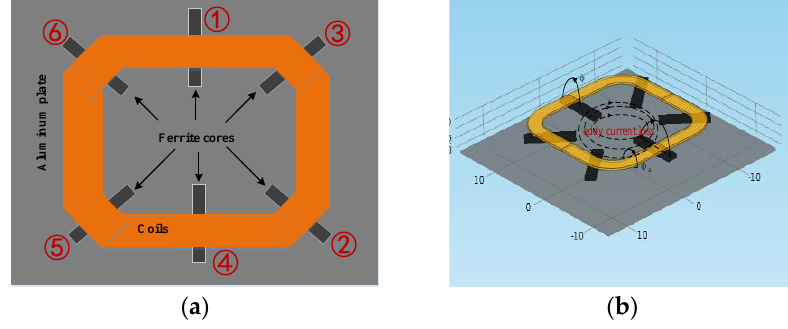
Figure 11. System model with ferrite cores: ( a ) 2D model; ( b ) 3D simulation model.